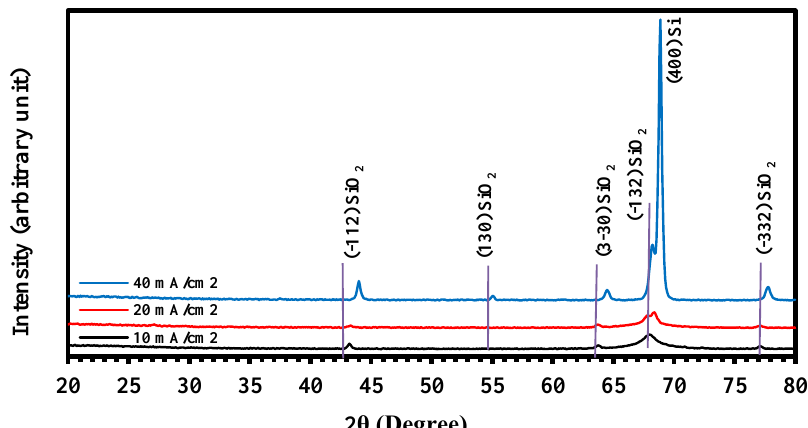
Fig.2: X-ray diffraction of p-PS prepared at current densities (10, 20, 40) Ma/cm 2 and 10 min etching